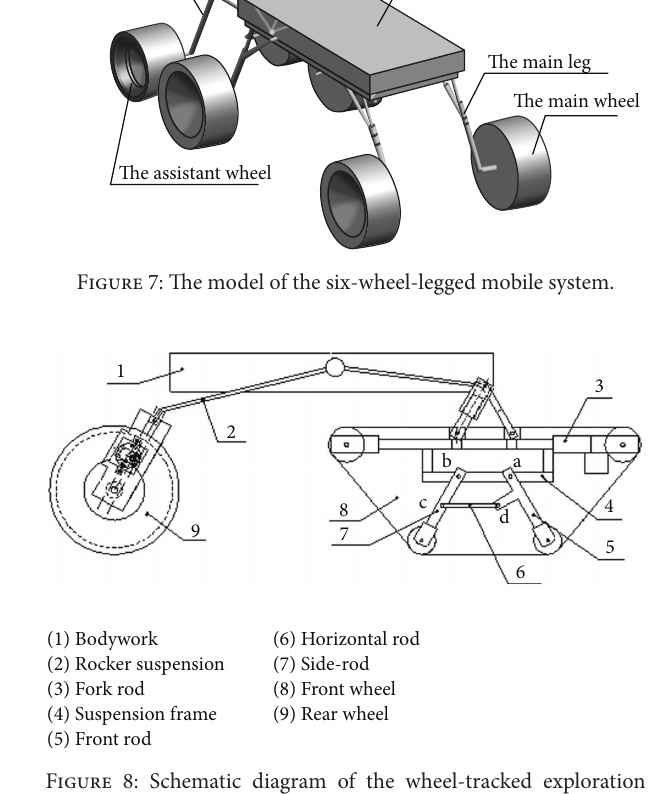
Figure 8: Schematic diagram of the wheel-tracked exploration